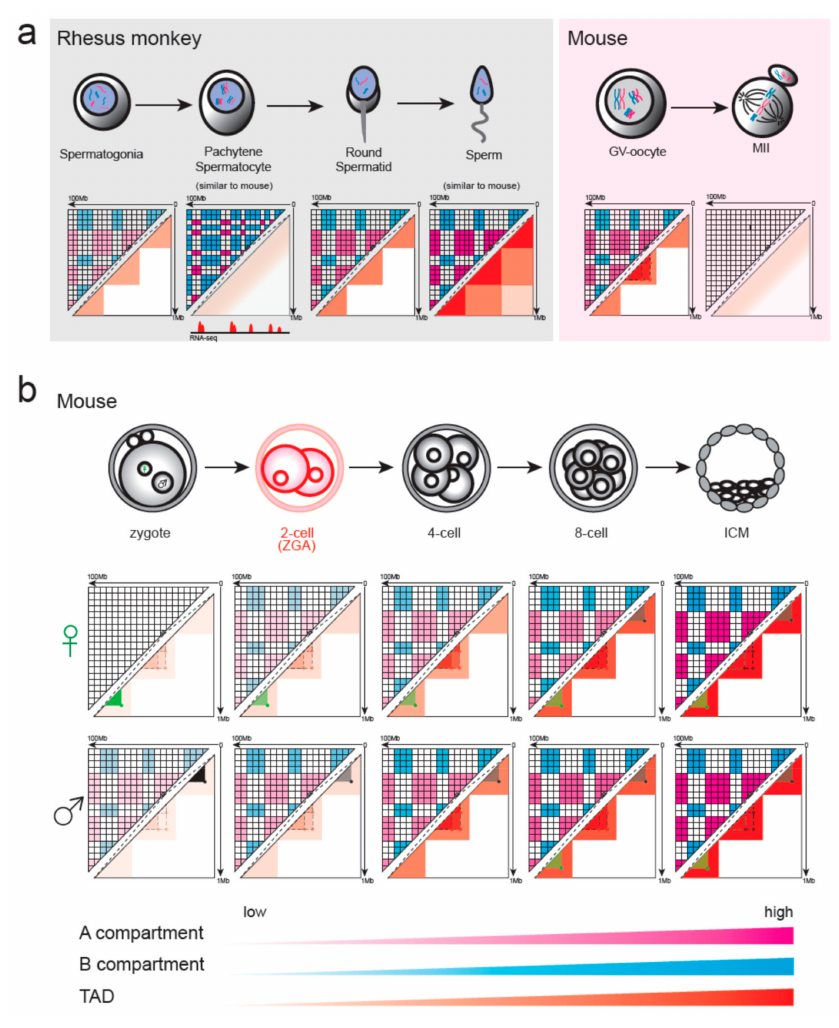
Figure 2. Chromatin remodeling in gametogenesis and pre-implantation development of mammals. The strength of compartments and TADs is illustrated with color bars with the darker color representing stronger structures. ( a ) Chromatin structure disappeared and was then reconstructed during rhesus monkey spermatogenesis. Pachytene spermatocyte had no conventional compartments A / B and TADs but showed a finer transcription-dependent compartment structure. Sperm showed extra-long-range interactions. Pachytene spermatocyte and mature sperm were also studied in the mouse and showed a pattern similar to that of the rhesus monkey. Germinal vesicle (GV) oocytes of the mouse had the typical higher-order structures, while MII had no such structures. ( b ) During mouse pre-implantation development, the strength of TADs, compartments, and loops is gradually enhanced. In the zygote, maternal nuclei had no compartmental structure although it is present in paternal nuclei. This strength di ff erence of compartments between the two alleles continued until the 8-cell stage. Maternal-specific (green color) and paternal-specific (gray color) loops exist until the 8-cell stage at which time the loops converged. The period of zygote genome activation was colored in